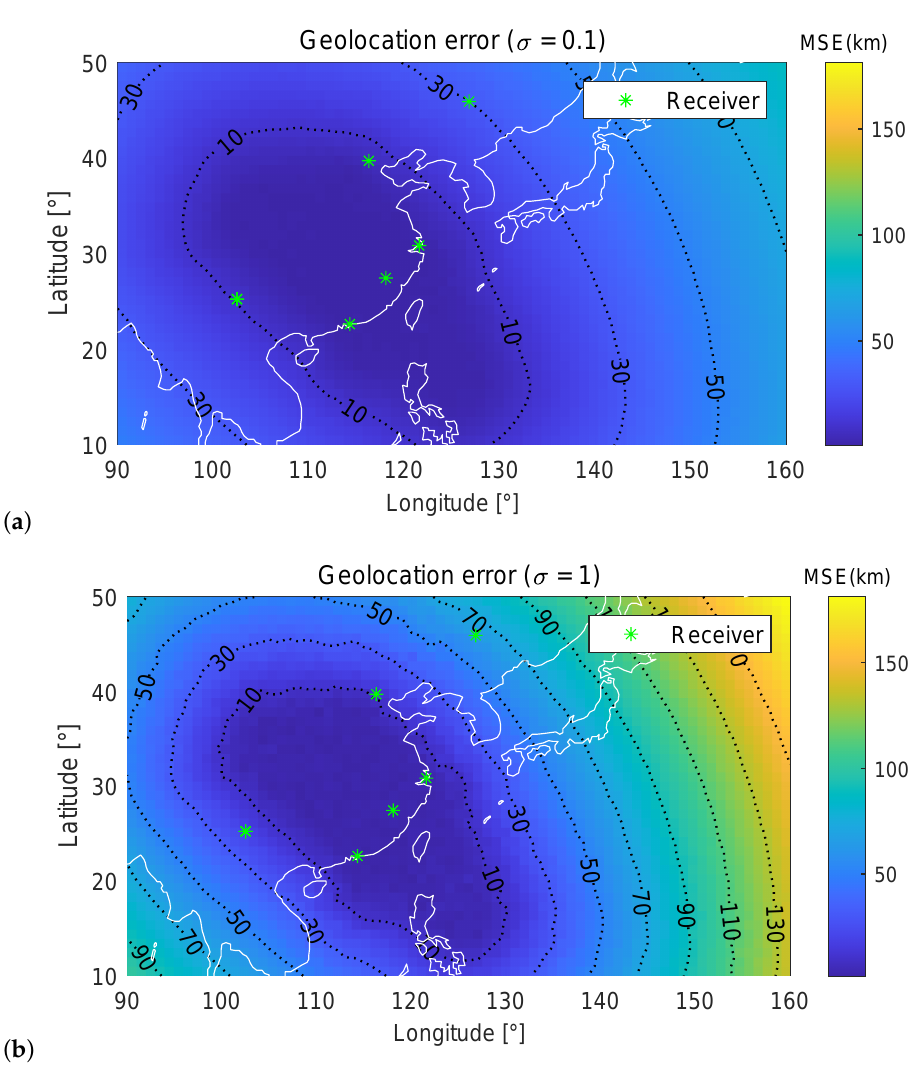
Figure 6. Geolocation error distributions for the first set of six fixed receivers under different σ